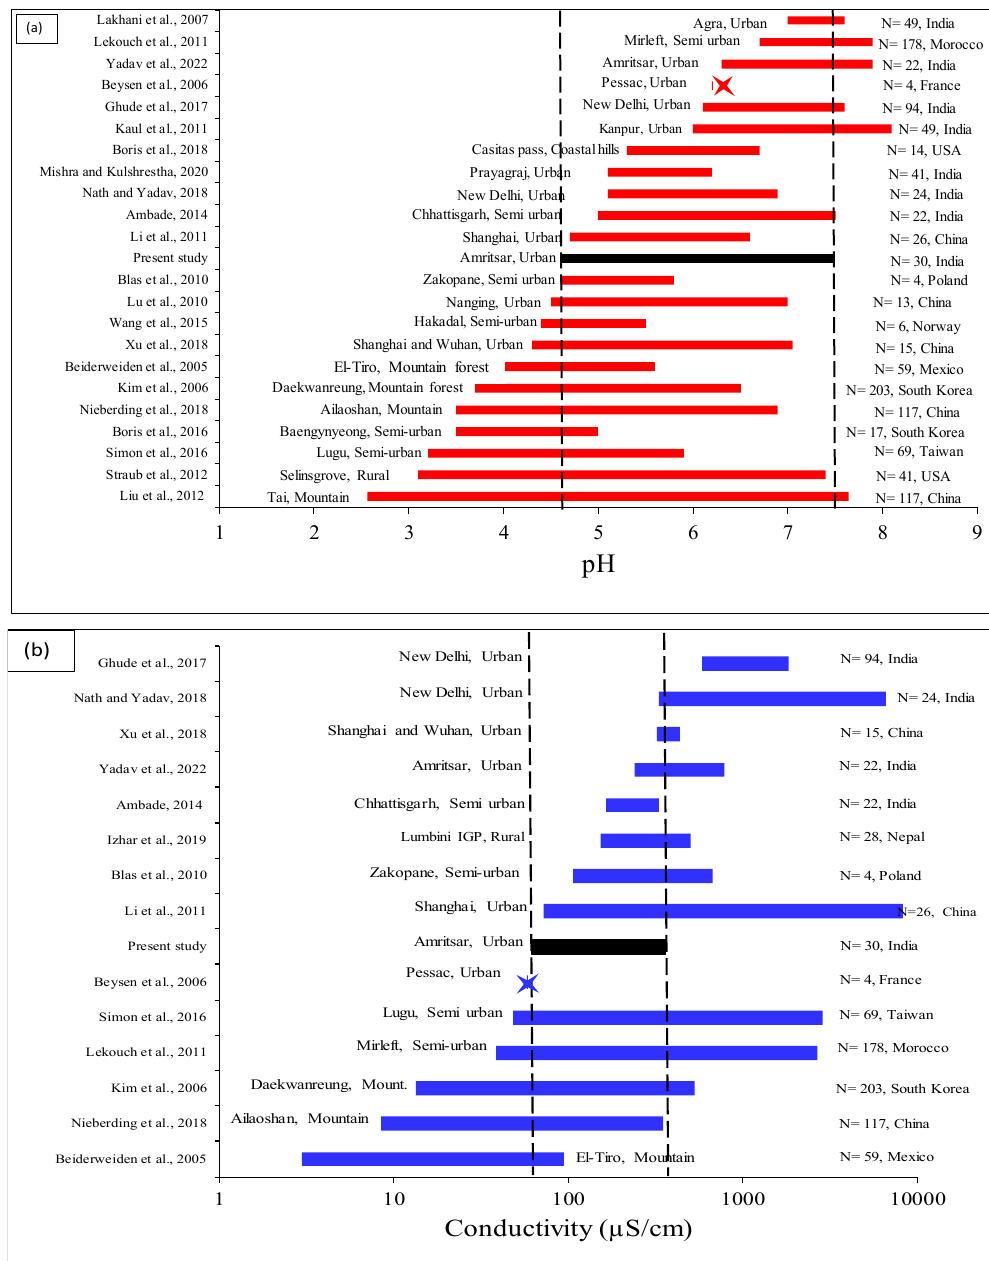
Figure 2. Global perspective of ( a ) pH and ( b ) conductivity in fog water studies (reproduced and modified with permission from [23]. References included are [8,17,23,33–50].